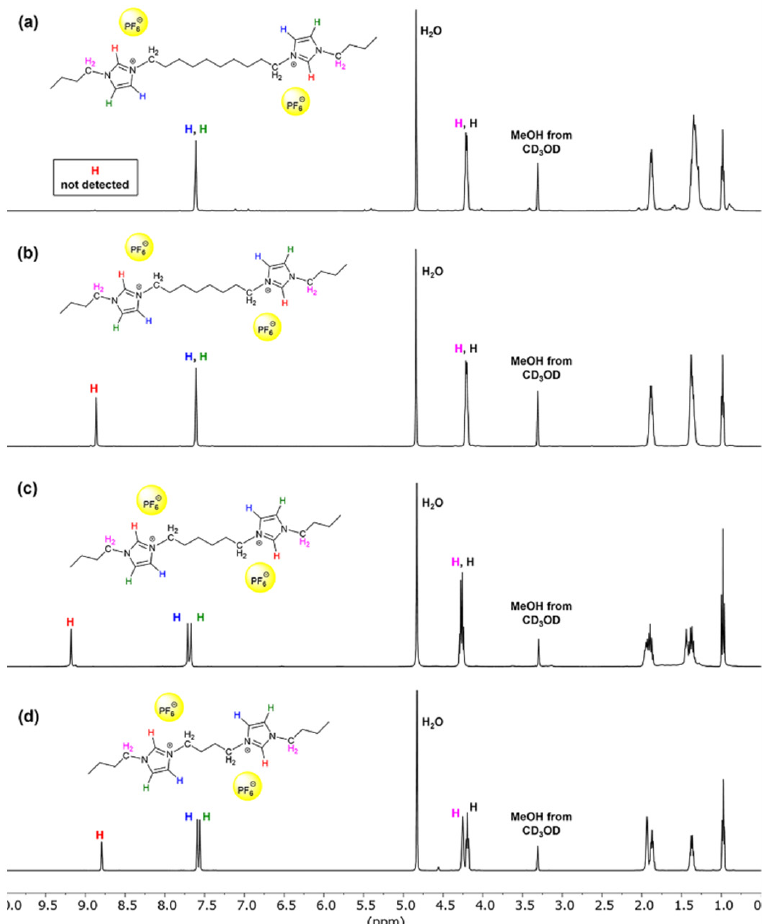
Figure 1. The 1 H-NMR spectra of the synthesized dicationic ionic liquid compounds in MeOH- d 4 : ( a ) 1,10- bis [Bim][PF 6 ] 2d , ( b ) 1,8- bis [Bim][PF 6 ] 2c , ( c ) 1,6- bis [Bim][PF 6 ] 2b , and ( d ) 1,4- bis [Bim][PF 6 ] 2a .